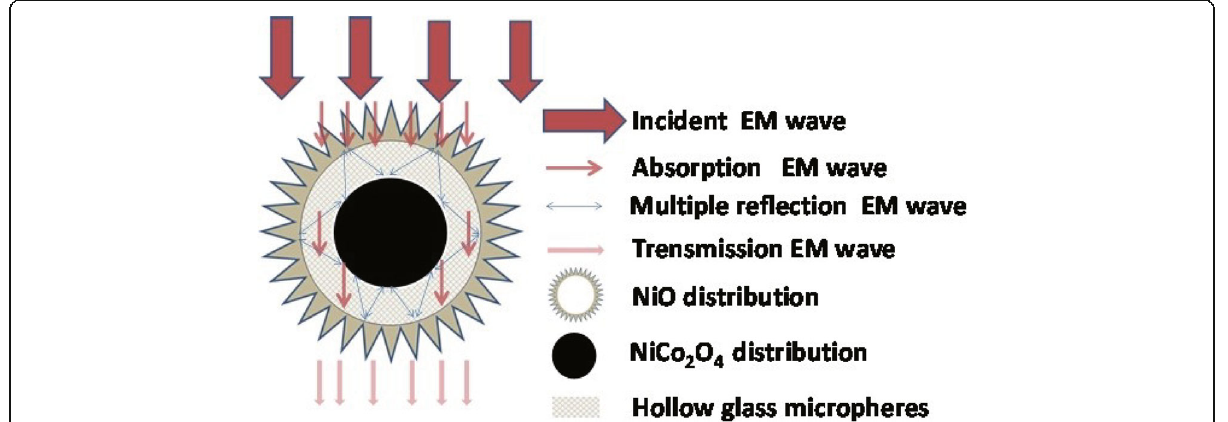
Fig. 6 A schematic illustration of NiO/NiCo 2 O 4 mixtures with yolk-shell structure to electromagnetic wave attenuation